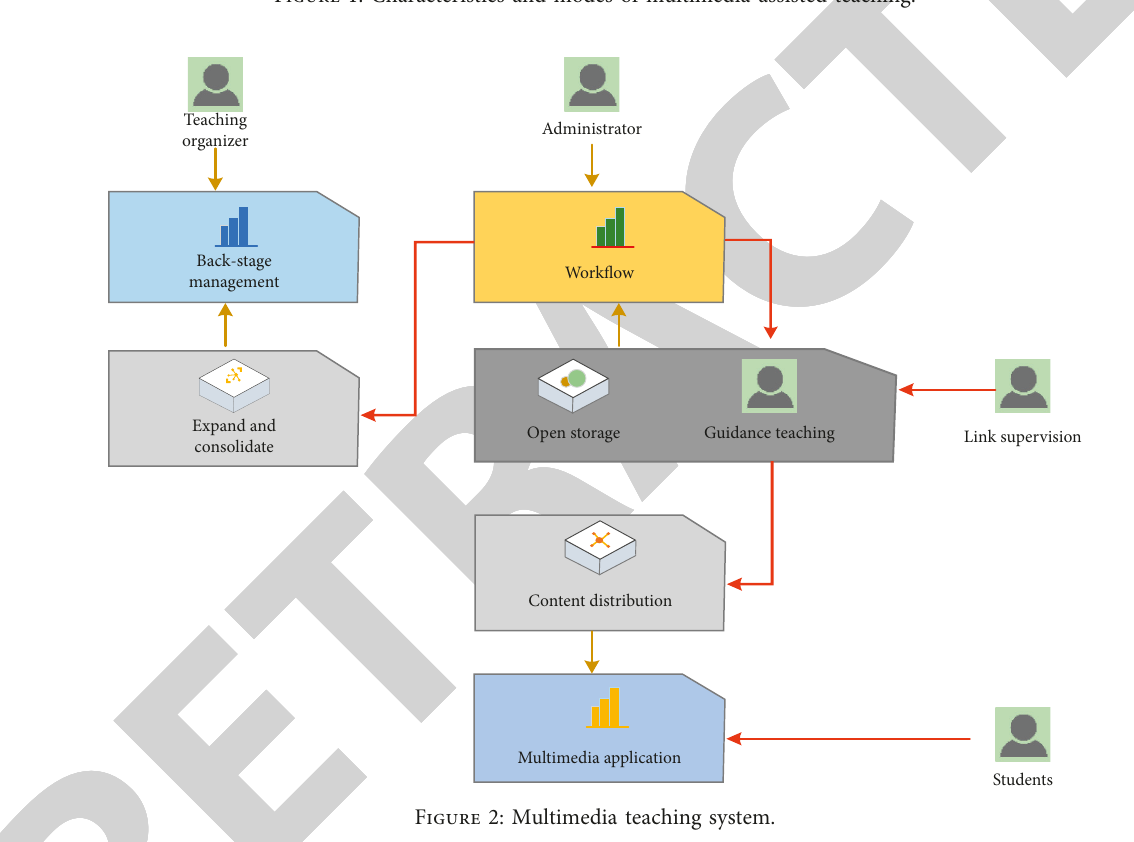
Figure 2: Multimedia teaching